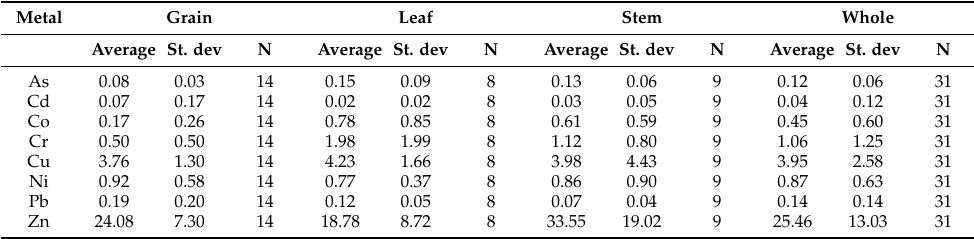
Table 3. Concentration of metals and metalloids rice parts and